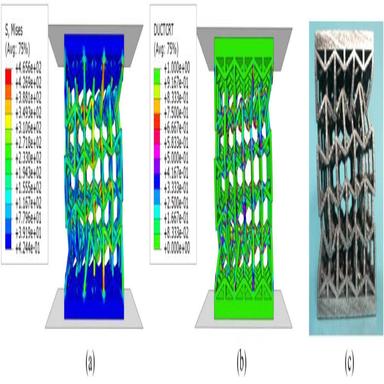
FEA results the CAD model: (a) Von Mises stress field of final step, (b) damage initiation field of final step. (c) experimental result.